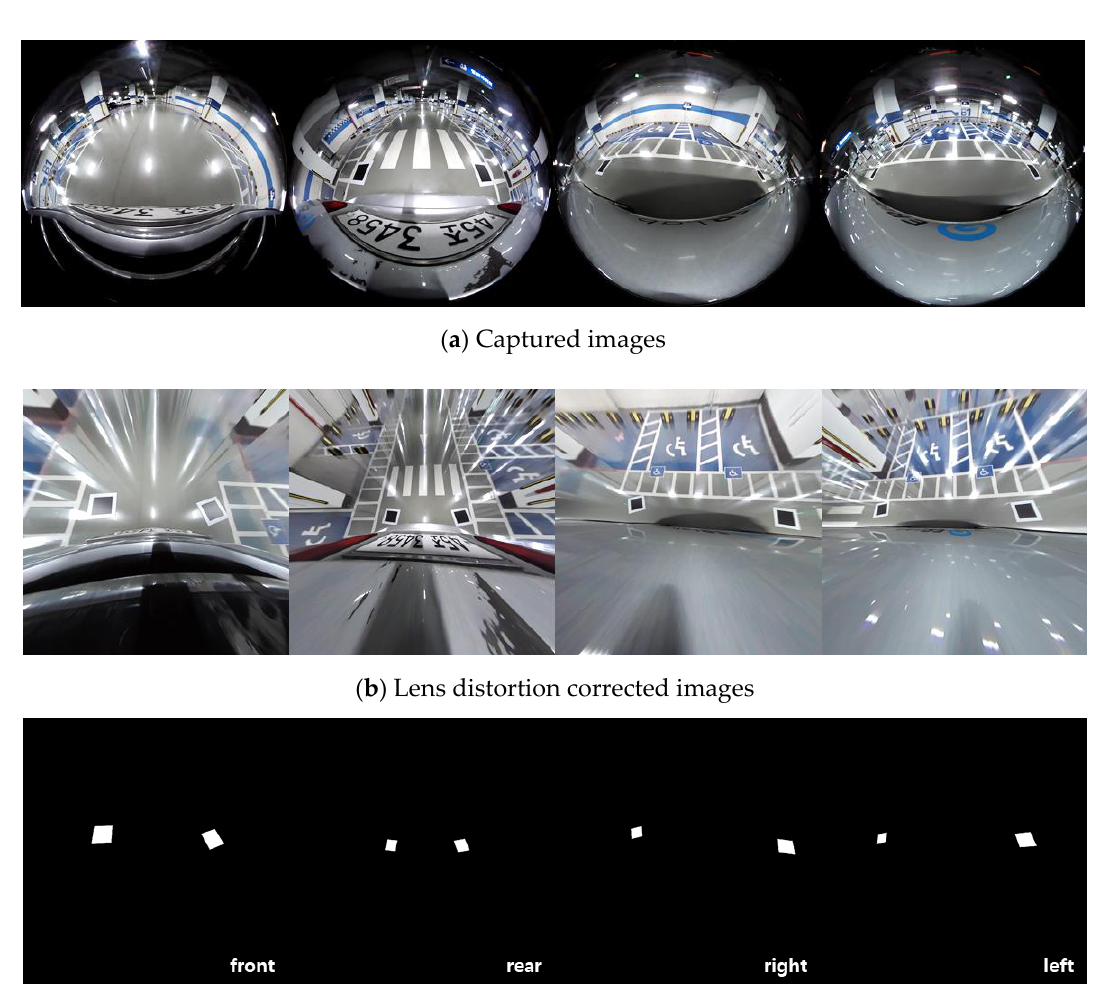
( d ) Right camera Figure 9. Four installed cameras for the field experiments. 4.1. Performance Evaluation Using a Real-Sized Vehicle We placed four calibration boards around the vehicle to evaluate the performance of the proposed method, as shown in Figure 10. Because the camera manufacturer provides the lens distortion parameters and intrinsic parameters, we can easily correct the lens distortion, as shown in Figure 11. In the lens distortion-corrected images, the shape of the calibration boards is quadrilateral. The calibration board detection detects two quadri- laterals per image, as shown in Figure 11c. The proposed method transforms the source images such that the detected quadrilateral calibration boards become squares. Figure 12 shows the generated AVM image using the proposed method. We can observe that all the calibration boards are similar to squares and the adjacent images are well aligned. Fur- thermore, even though there are no calibration boards in the nonoverlapping ROI, the source image in the nonoverlapping ROI can also be transformed into a well-calibrated AVM image.